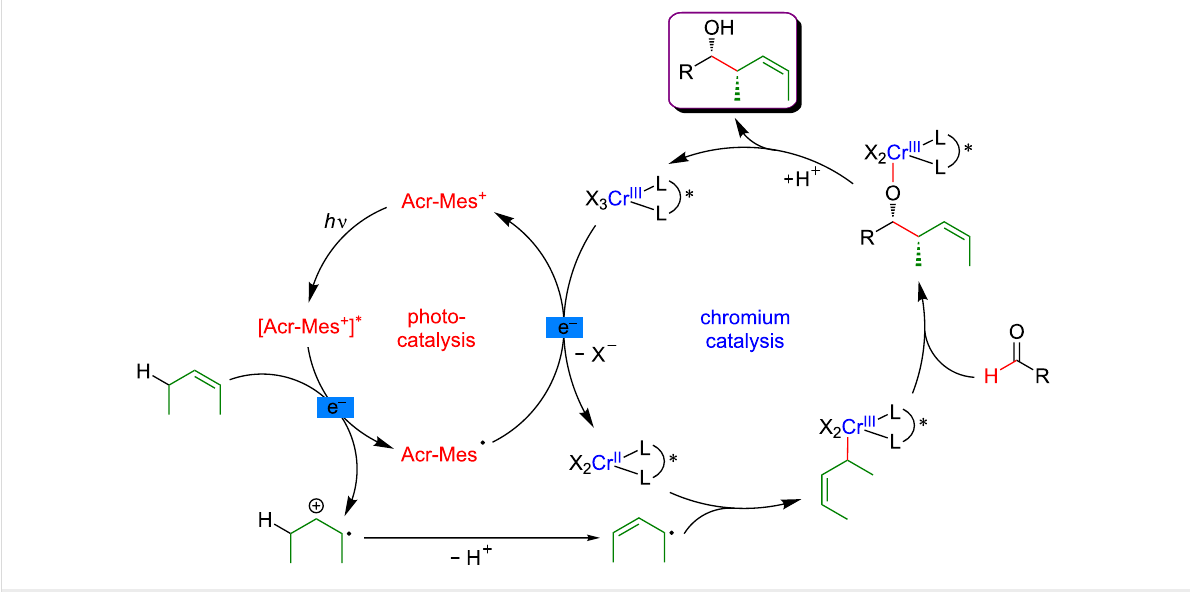
Figure 74: Proposed mechanism for the asymmetric allylation of aldehydes via dual catalysis.